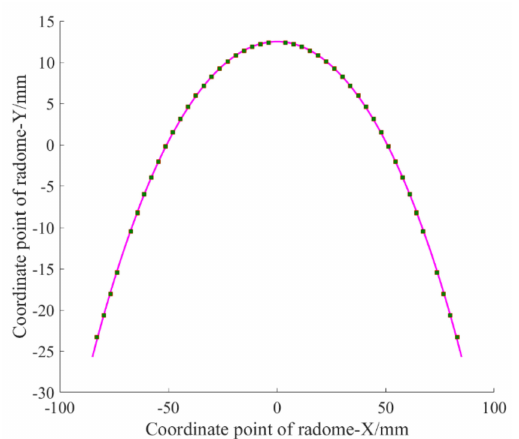
Figure 1. Fitting function with polynomial